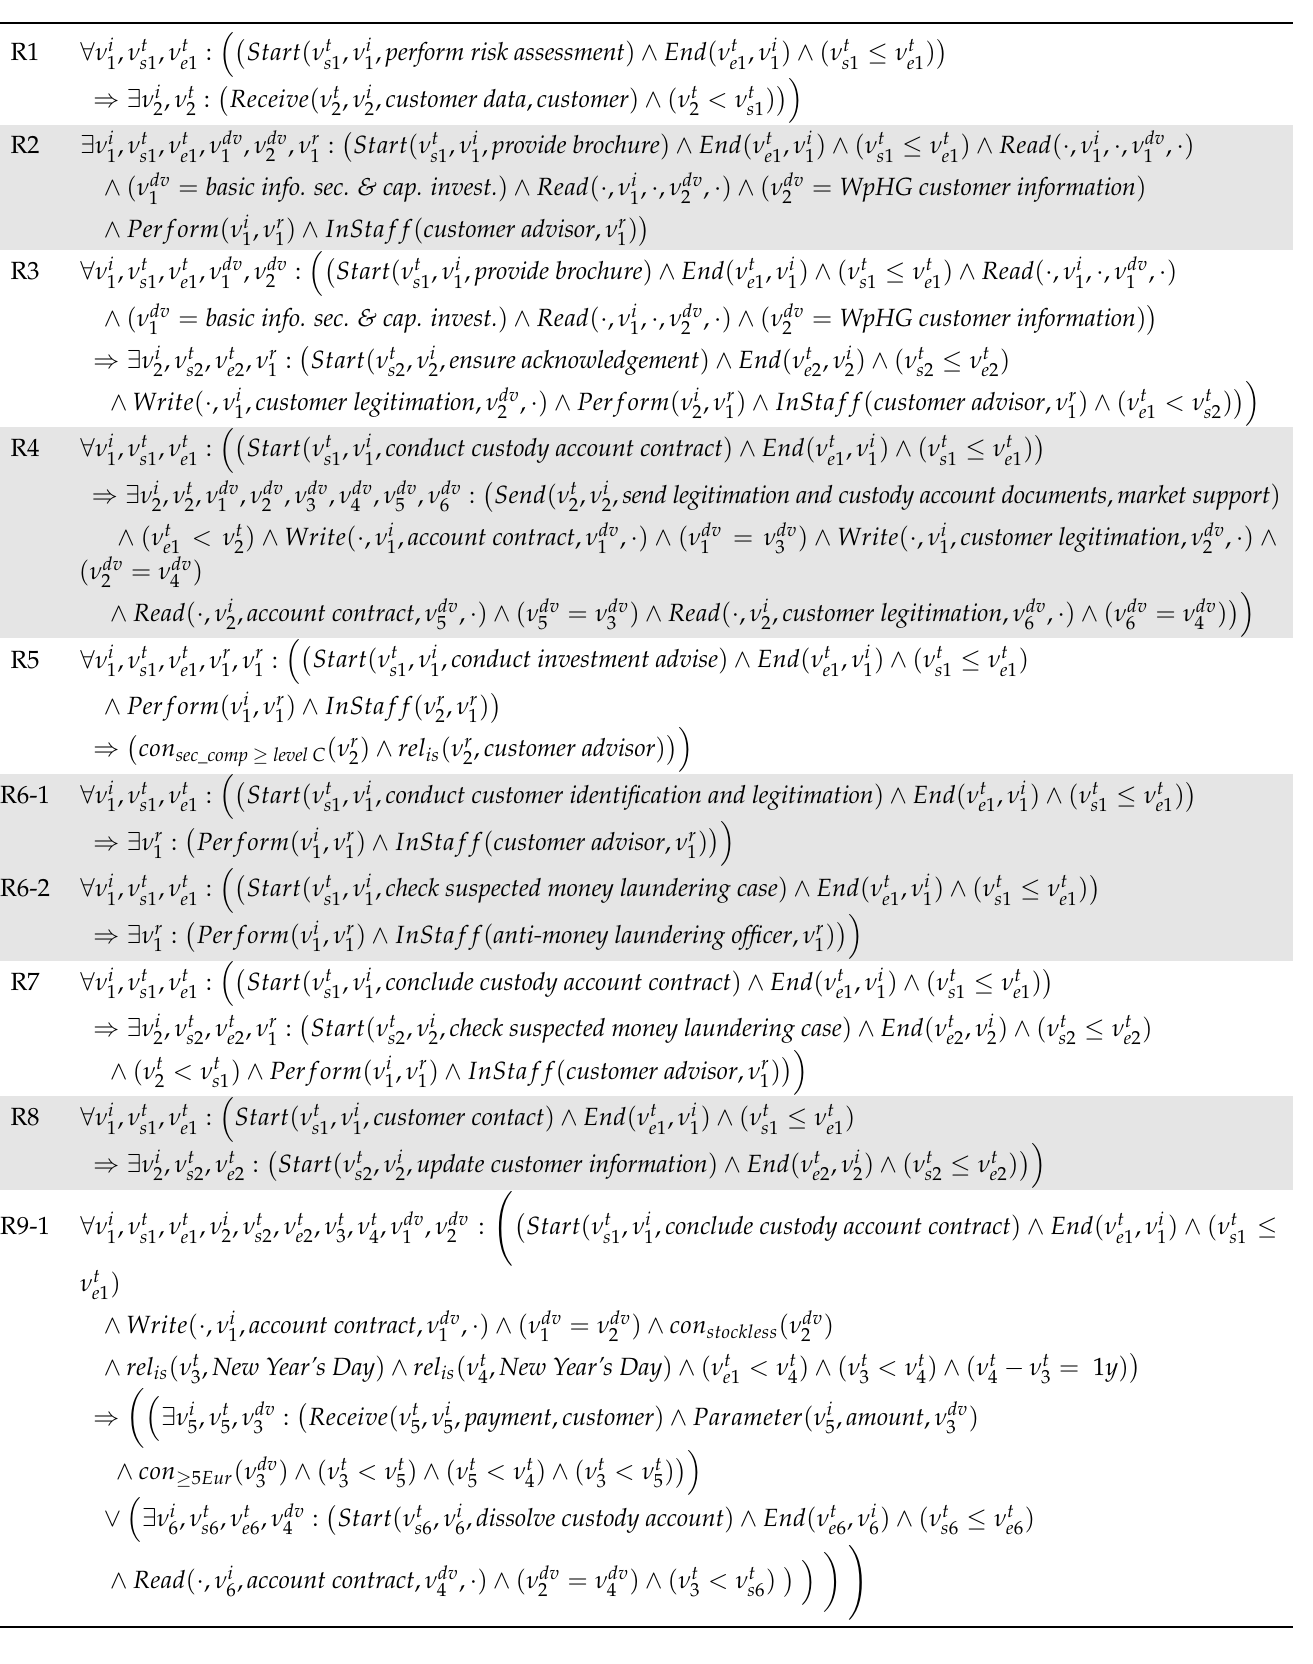
Table 10. FOL expressions of eCRG